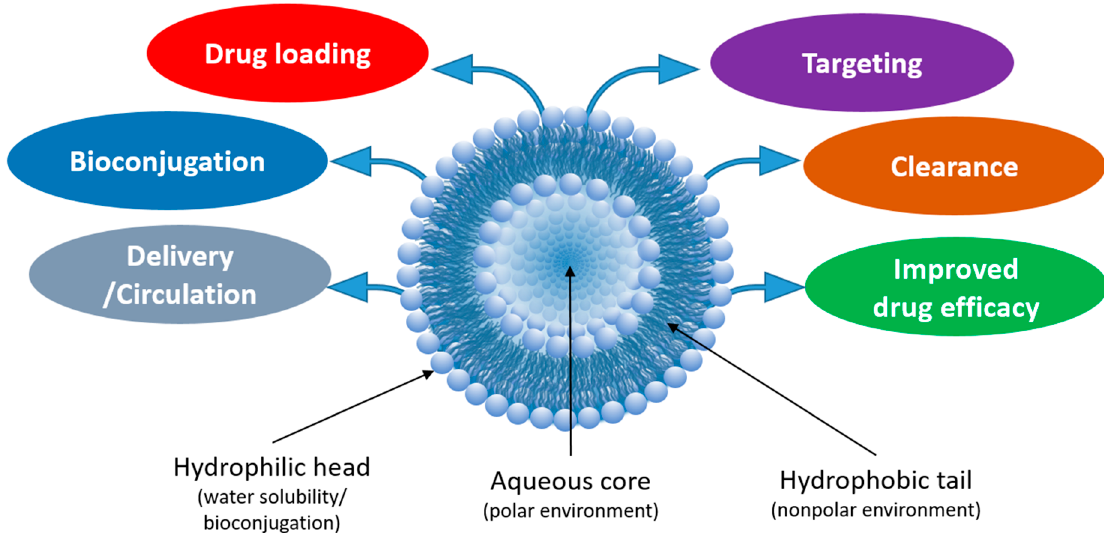
Figure 1. Structural features of liposomes and their advantageous features for improved drug delivery and therapeutic efficacy. Liposomes feature an aqueous core surrounded by a lipid bilayer, which creates an environment for loading hydrophilic or hydrophobic drugs, respectively. Functional groups on the lipid head enable conjugation to polymers, peptides, proteins, etc., for enhanced targeting, circulation, and overall drug efficacy.